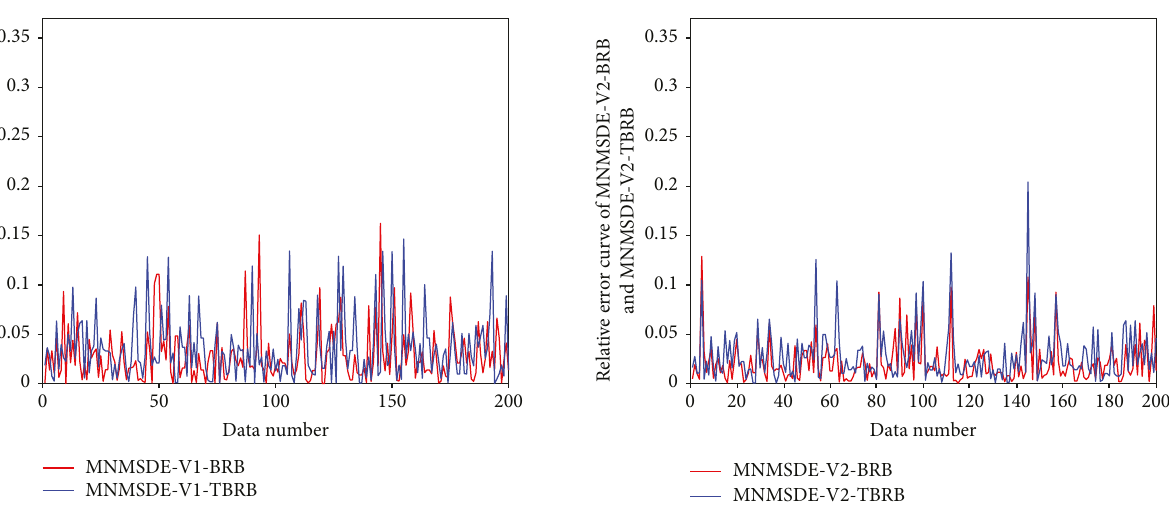
Figure 16: The relative error of MNMSDE_V2-BRB and MNMSDE_V2-TBRB.